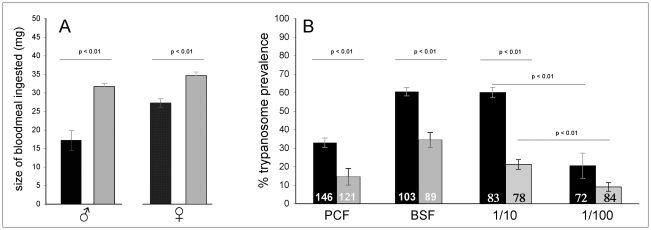
Comparison of average bloodmeal volumes and midgut infection rates in teneral G. m. morsitans.Male and female flies were aged 24 h.p.e (black bars) or 48 h.p.e. (grey bars) at the time of the infective bloodmeal. Panel A shows the significant differences in volume (mg) of a first bloodmeal ingested by young and old male and female flies. Panel B shows the variability of midgut infection rates in young and old male flies fed PCF or different concentrations of BSF T. b. brucei TSW196. Parasite (BSF) concentrations in the bloodmeal were 5×104 trypanosomes/mL (1/10) and 5×103 trypanosomes/mL (1/100). The numbers within the bars represent the number of flies scored from three replicate experiments.